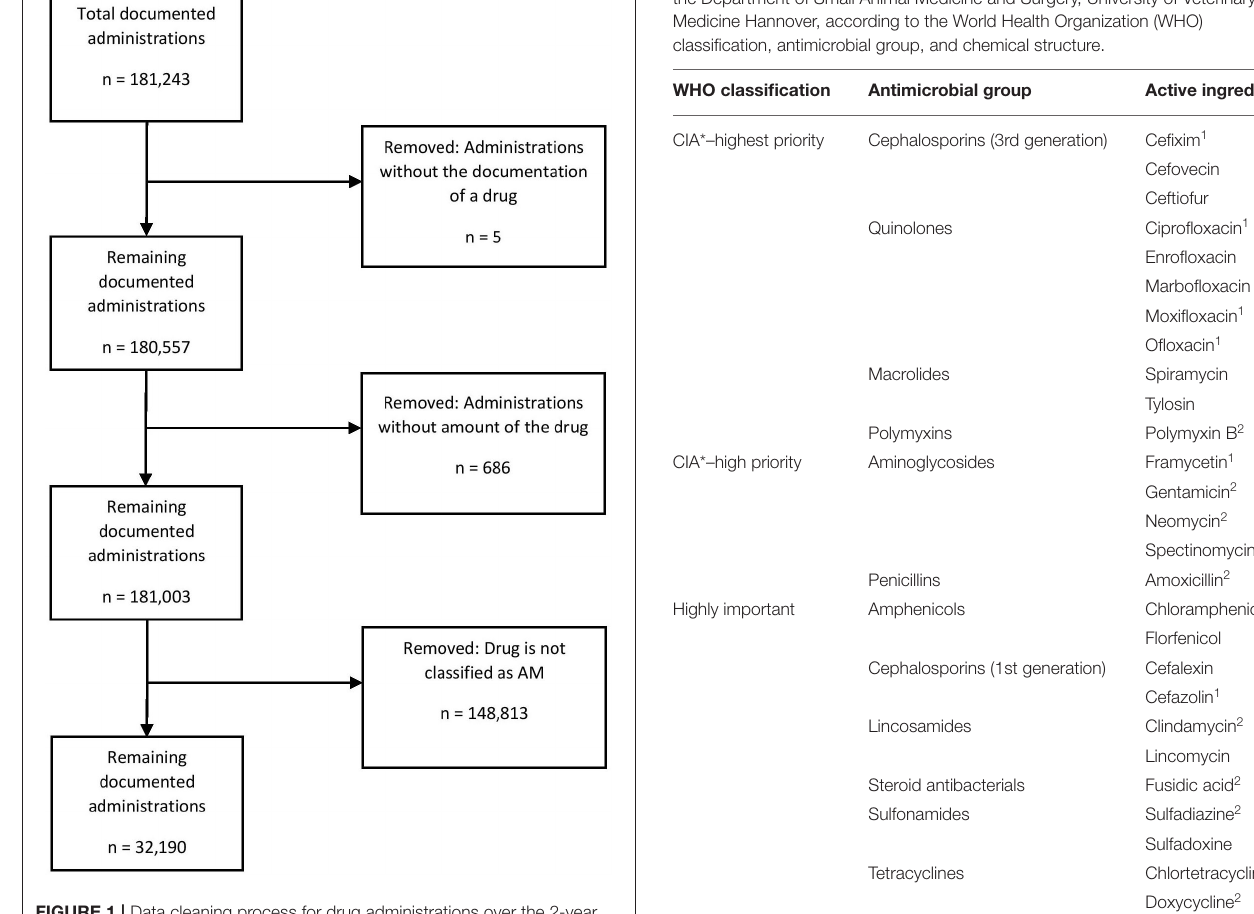
FIGURE 1 | Data cleaning process for drug administrations over the 2-year study period at the Department of Small Animal Medicine and Surgery, University of Veterinary Medicine.